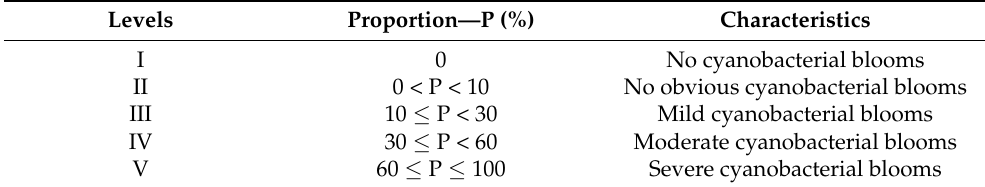
Table 5. Grading standard of degree of cyanobacterial bloom based on the evaluation of pollution area ratio.